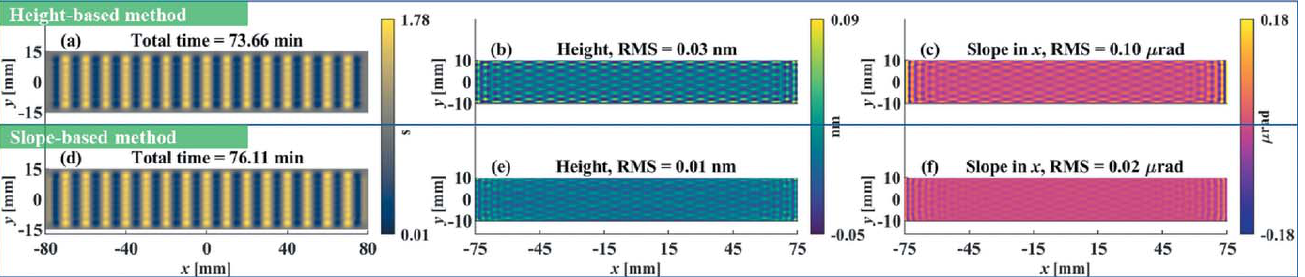
Figure 4 Dwell time, residual height errors and residual slope errors estimated from the height-based method ( a – c ) and slope-based method ( d – f ), respectively, for the sinusoidal surface shown in Figs. 1( c ) and 1( d ) with f x = 10 mm (cid:2) 1 .